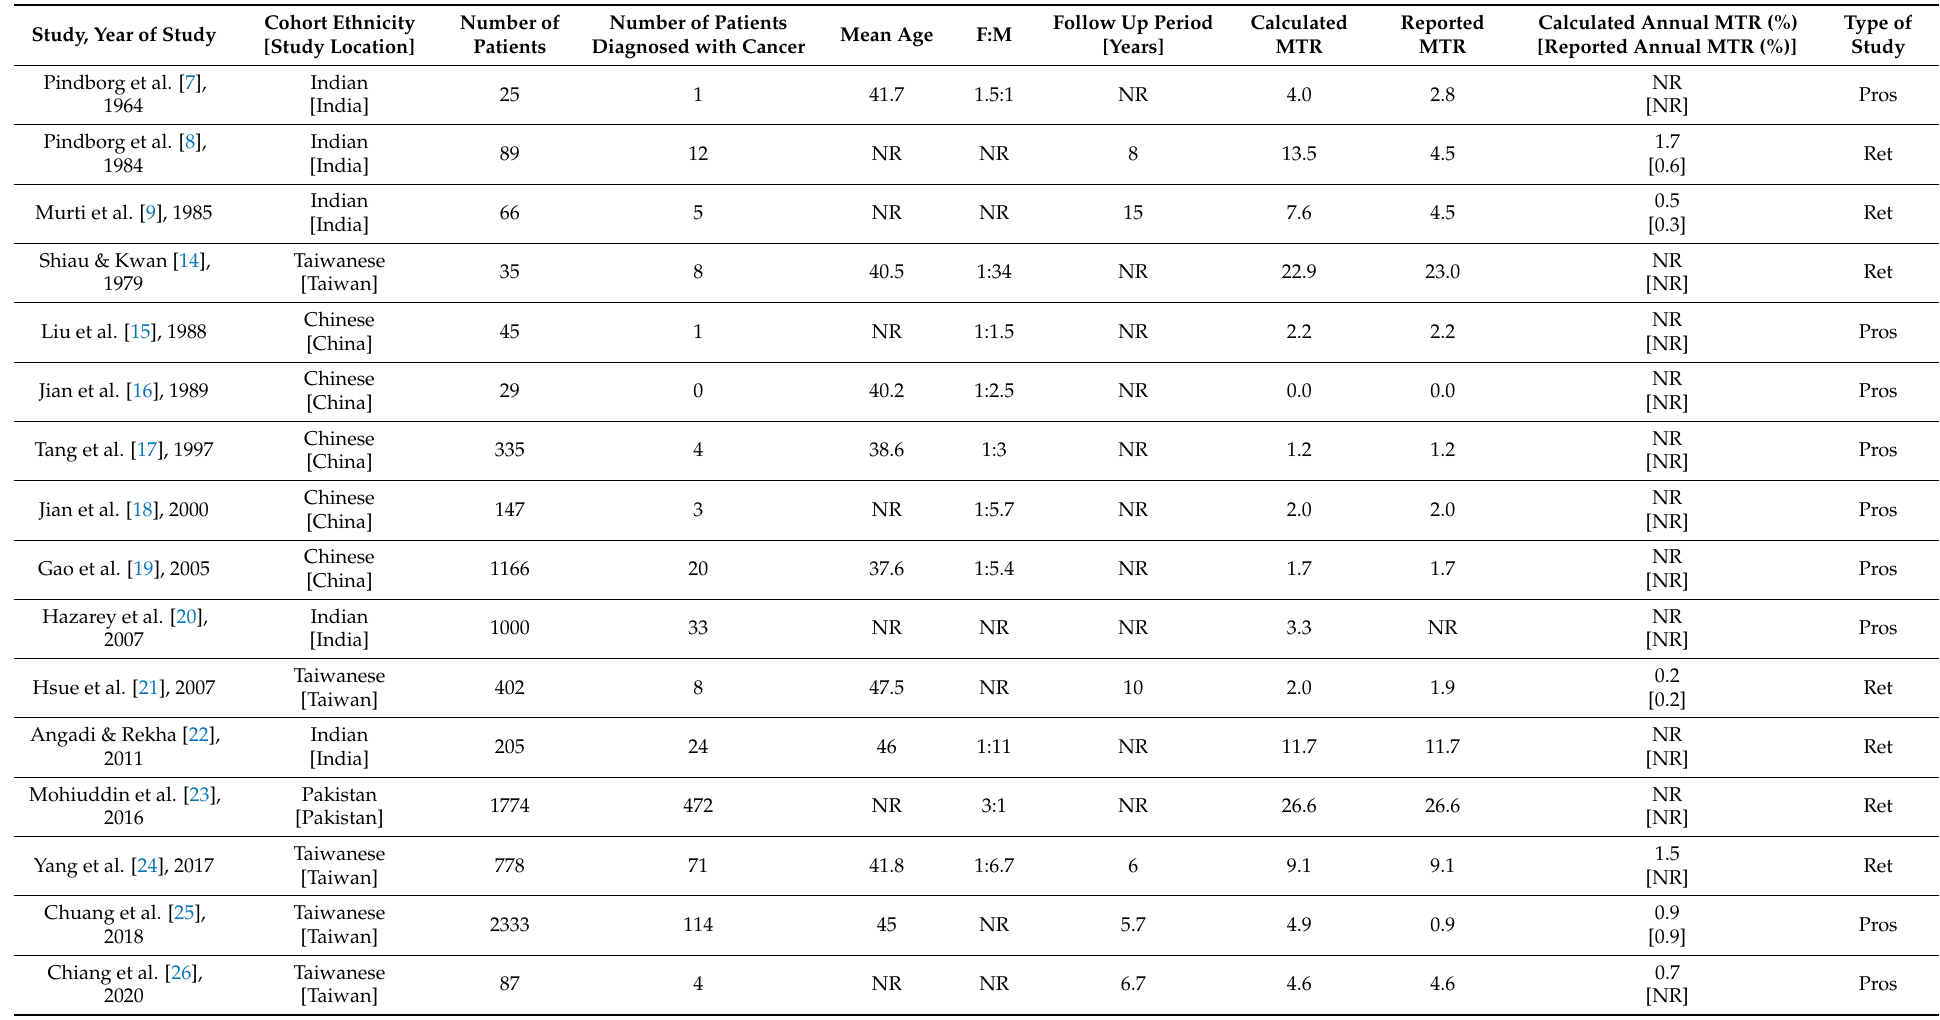
Table 1. Cohort and patient details of the reviewed articles. NR, Not Reported. Pros, Prospective. Ret, Retrospective. F:M, female: male. MTR, Malignant Transformation